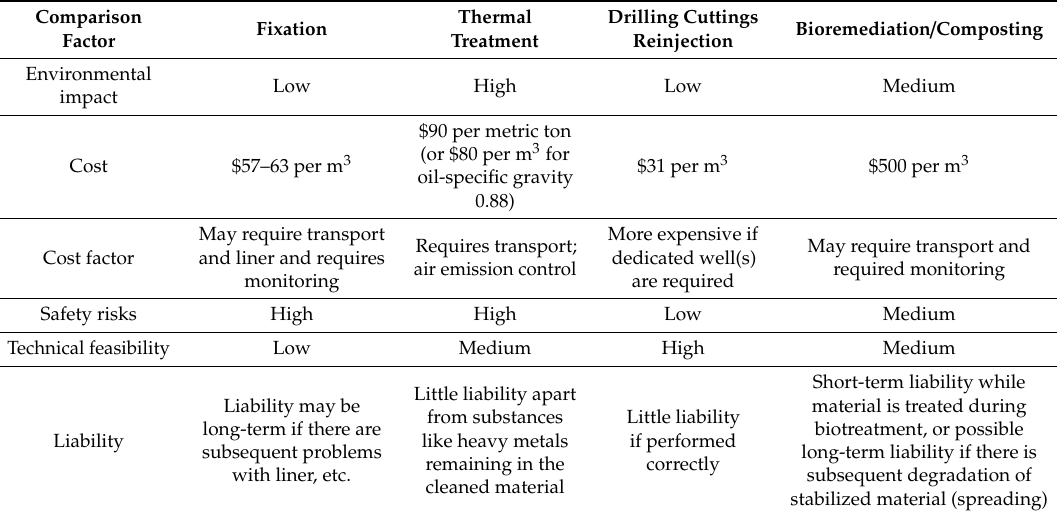
Table 2. Comparison between di ff erent disposal methods for waste from drilling activities